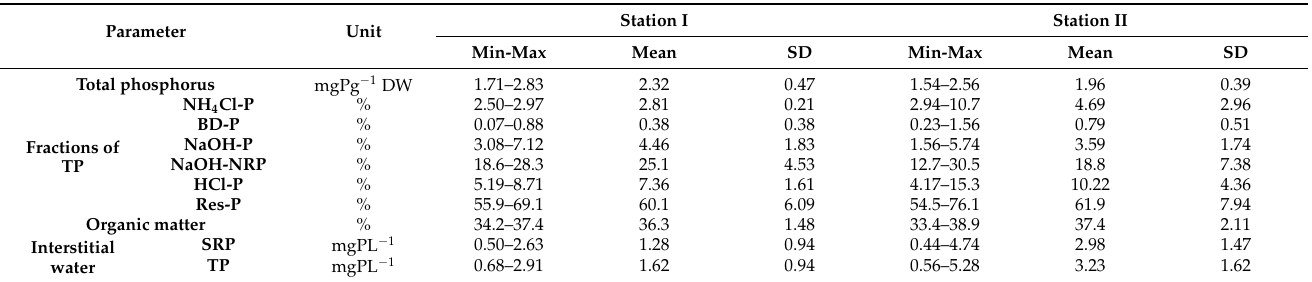
Table 9. Concentration of total phosphorus, percentage share of its individual fractions, organic matter in bottom sediments and soluble reactive phosphorus and total phosphorus in interstitial waters at two sampling stations in Raczy´nskie